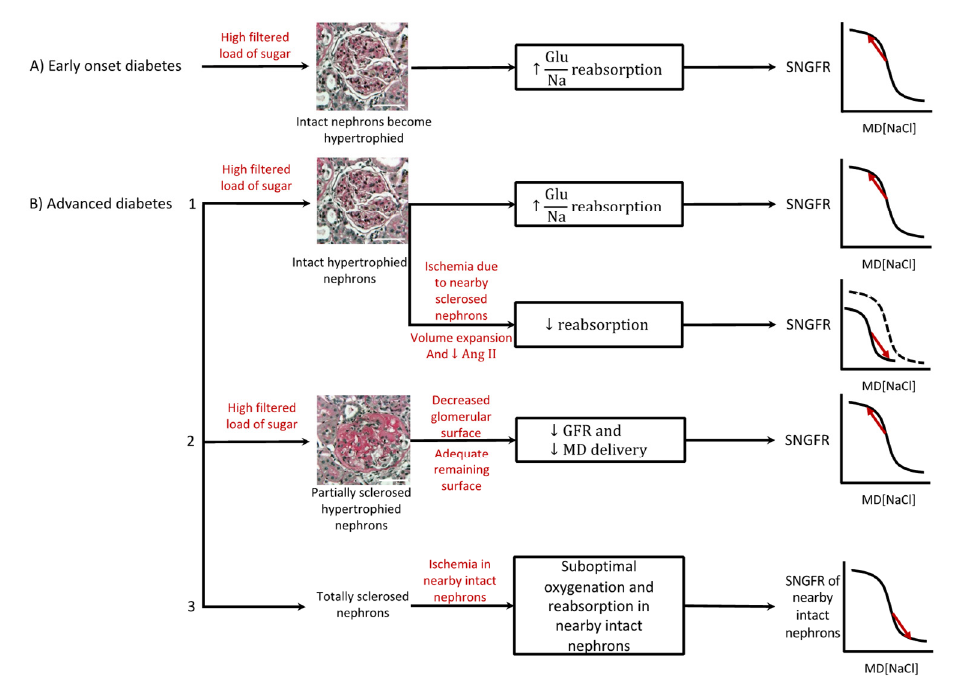
Figure 2. Macula densa (MD) solute delivery and the tubuloglomerular feedback (TGF) response in early and advanced diabetic nephropathy. ( A ) Shows intact, hypertrophied nephrons in early diabetic nephropathy, which would result in increased solute reabsorption proximal to the macula densa and deactivation of the TGF system and hyperfiltration. ( B 1 ) Shows intact hypertrophied nephrons in advanced diabetic nephropathy and how the macula densa salute delivery and the TGF response might be changed based the extent of sclerosis in nearby nephrons (dashed curve shows normal TGF curve). ( B 2 ) Shows focally sclerosed, hypertrophied nephrons in advanced diabetic nephropathy, which would result in decreased GFR and macula densa salute delivery and deactivation of the TGF system. ( B 3 ) Shows globally sclerosed nephrons and how they might affect nearby intact nephrons [55]. Scale bars indicate 50 μ m.